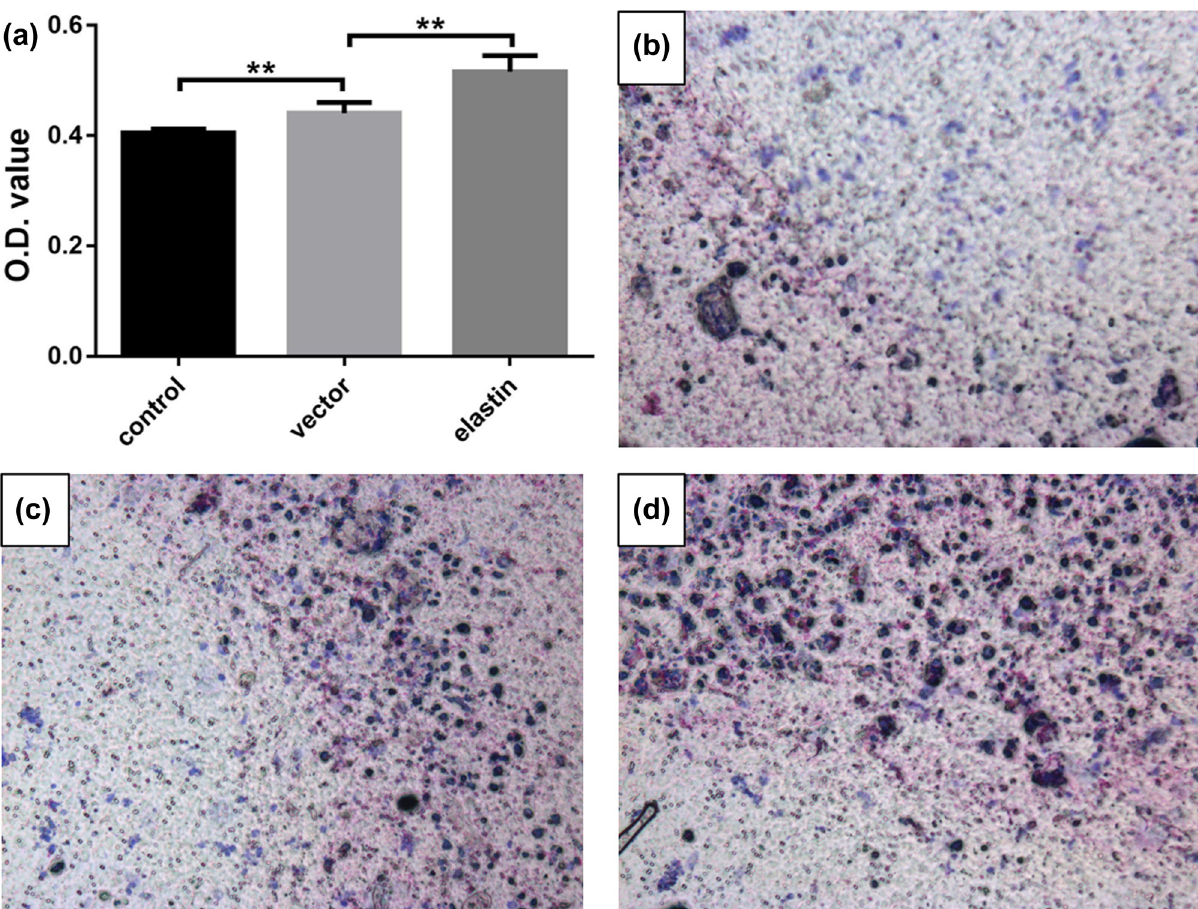
Figure 5: Calculated result of ( a ) cell invasion, ( b ) staining images of control, ( c ) empty vector, and ( d ) elastin gene - loaded vector groups (× 100 )